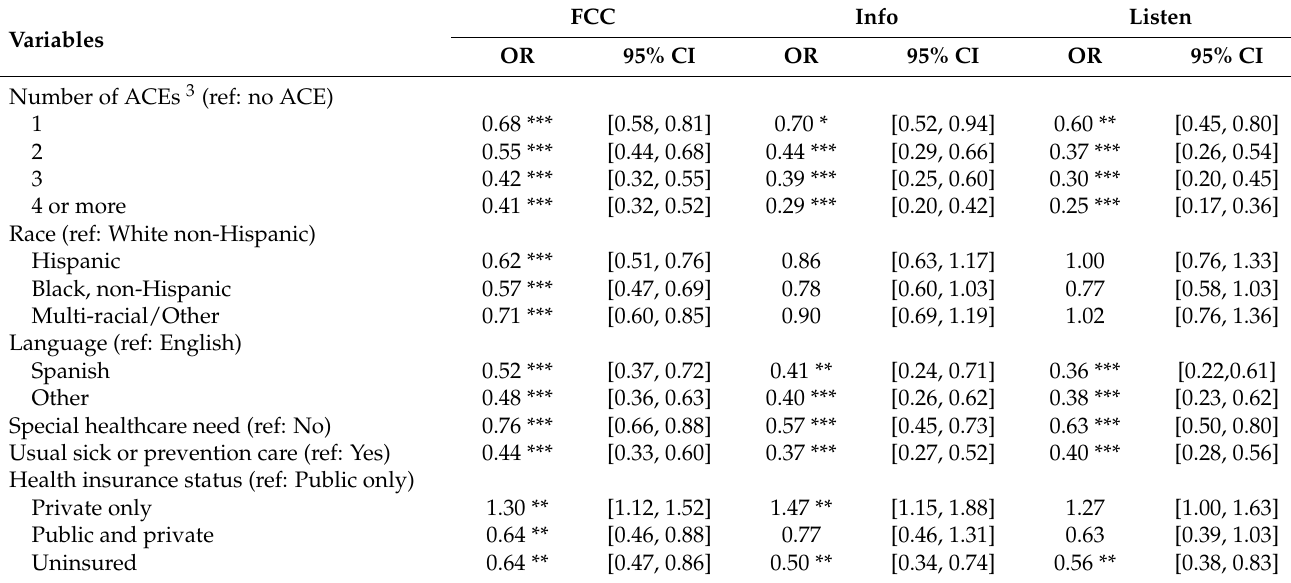
Table 3. Logistic Regression Models Predicting Family Centered